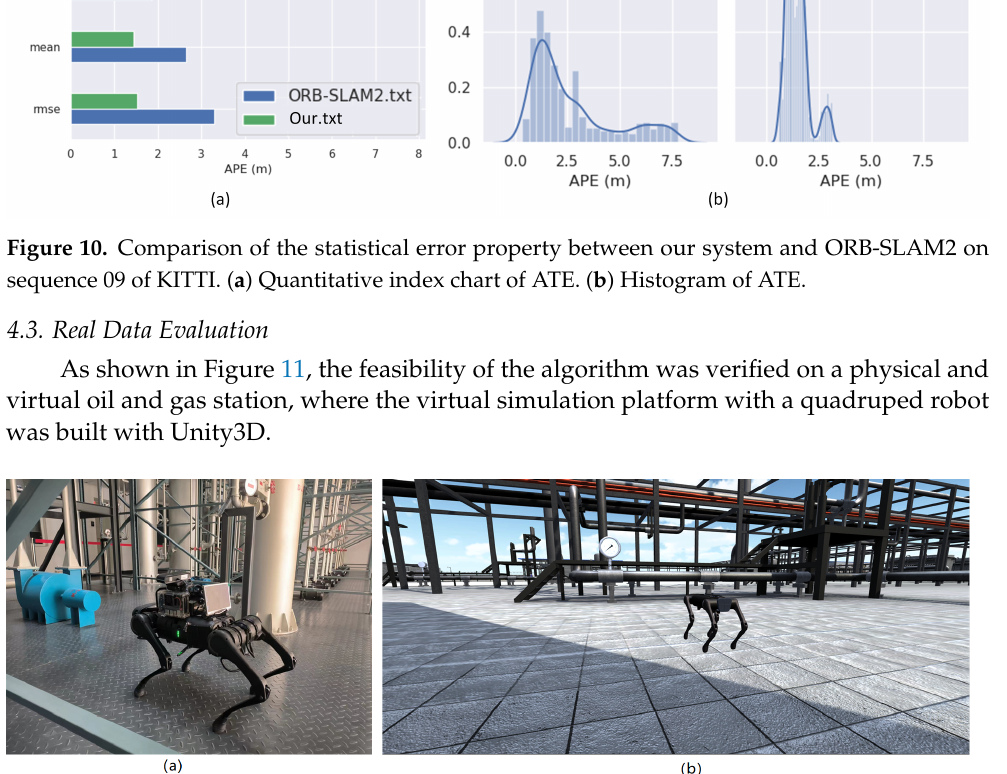
Figure 11. The experimental robot platform. ( a ) The physical experimental robot platform with robot hardware including a camera, depth camera, and IMU. An additional GPS/RTK was used for the ground-truth estimation. ( b ) The virtual simulation